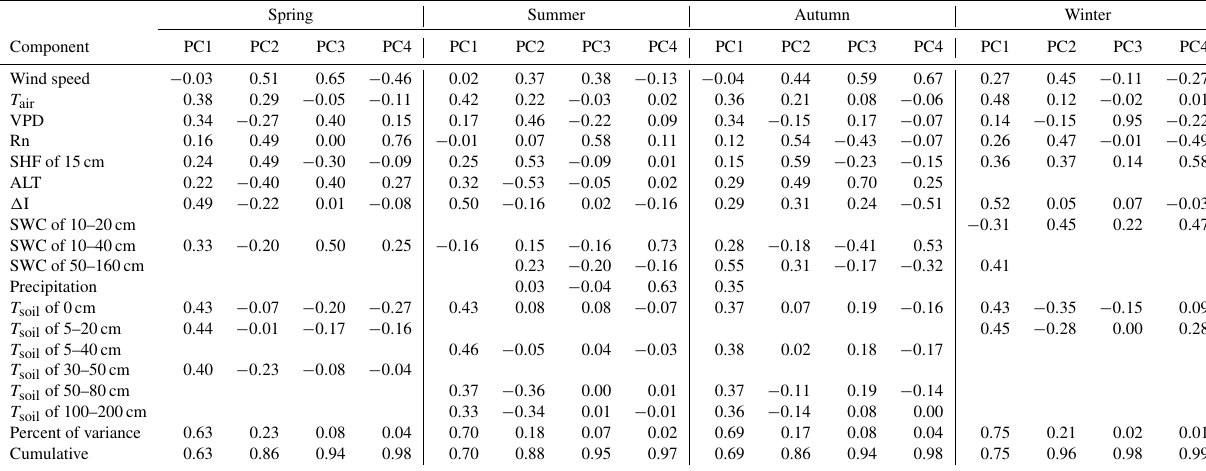
Table 4. Principal component analysis (PCA) of the environmental factors. Spring Summer Autumn Winter